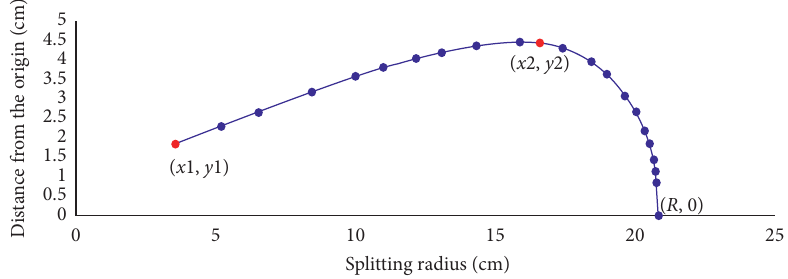
Figure 9: Point map on the curve.